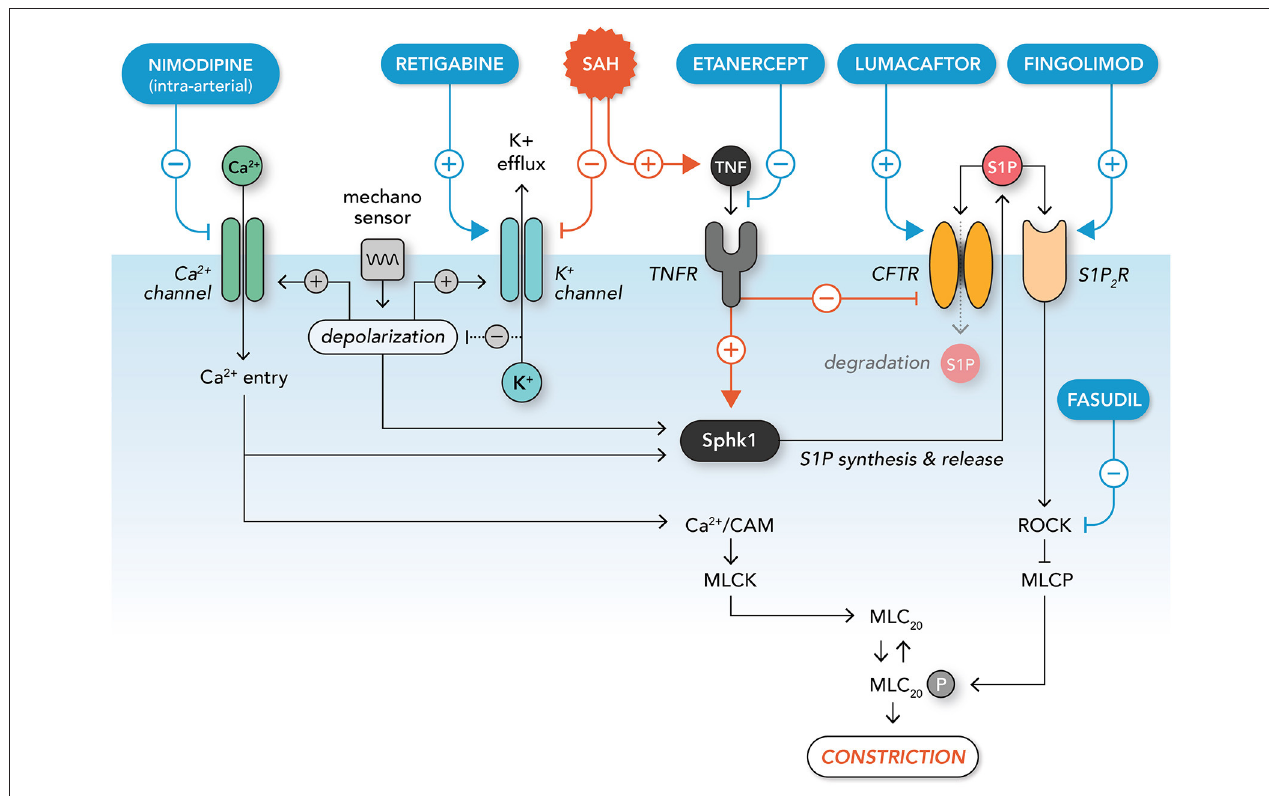
FIGURE 3 | Molecular mechanisms augmenting microvascular constriction in subarachnoid hemorrhage and potential interventions. A mechanosensitive complex initiates myogenic vasoconstriction via membrane potential depolarization: this leads to calcium entry via opening of voltage-gated calcium channels; voltage gated potassium channels also open, leading to hyperpolarizing potassium efflux that limits the extent of depolarization (negative feedback). Intracellular calcium activates calmodulin (CAM), myosin light chain kinase (MLCK) and the contraction apparatus. In addition, calcium entry and depolarization lead to the activation of sphingosine kinase 1 (Sphk1), which synthesizes and releases sphingosine-1-phosphate (S1P) into the extracellular compartment. Extracellular S1P activates the S1P2 receptor subtype (S1P 2 R), thereby activating the Rho-associated protein kinase (ROCK) signaling pathway. ROCK signaling inhibits myosin light chain phosphatase (MLCP), which enhances MLCK’s activation of the contractile apparatus. Extracellular S1P is sequestered from S1P 2 R by the cystic fibrosis transmembrane conductance regulator (CFTR), which transports S1P across the plasma membrane for degradation. In subarachnoid hemorrhage (SAH), potassium channels are down-regulated, leading to enhanced depolarization through disinhibition. SAH also stimulates inflammatory tumor necrosis factor signaling, which down-regulates CFTR expression and enhances the activation of Sphk1. This increases pro-constrictive S1P / S1P 2 R / ROCK signaling, which enhances constriction via the inhibition of MLCP. Therapeutics targeting these pathological processes include: (i) intra-arterially-delivered nimodipine (calcium channel blocker; limits calcium entry), (ii) retigabine (potassium channel activator; reduces depolarization), (iii) etanercept (inhibits TNF signaling; reduces S1P synthesis and increases S1P degradation), (iv) lumacaftor (increases CFTR expression; increases S1P degradation), (v) fingolimod (stimulates S1P receptor internalization; inhibits ROCK activation), and (vi) fasudil